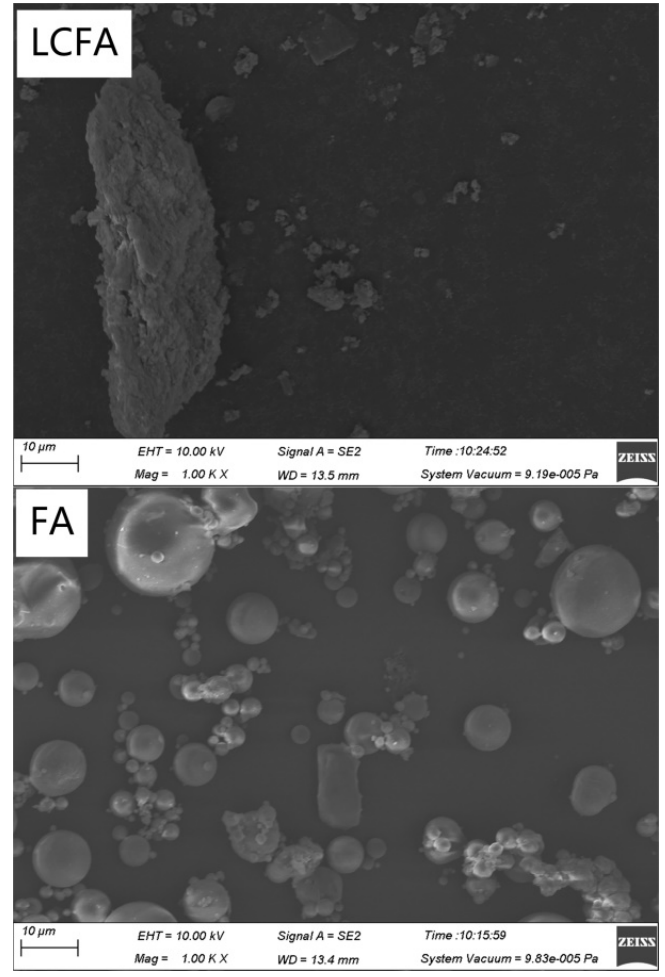
Figure 3. Microstructure of LCFA and FA.